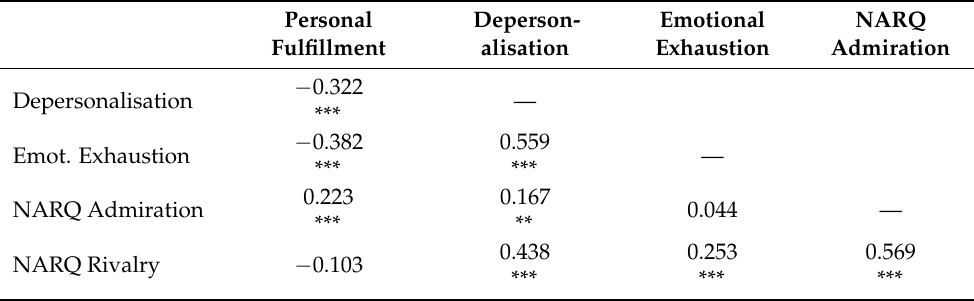
Table 3. Correlation matrix of the relevant variables.